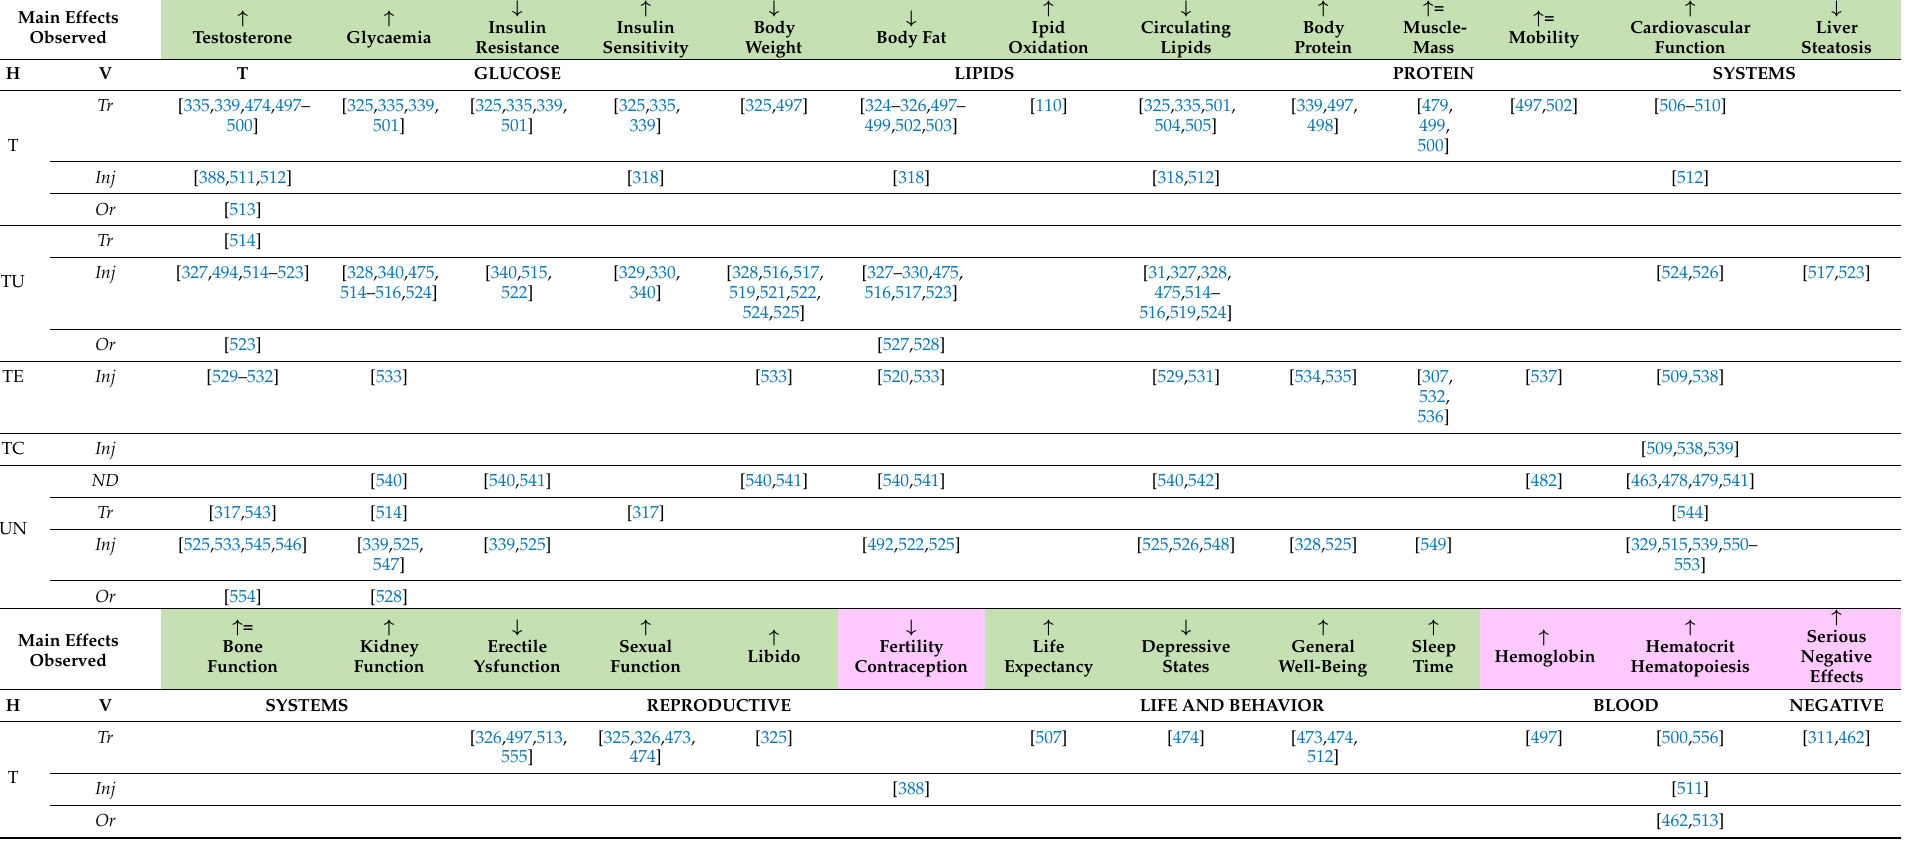
Table 2. Main effects on men of prolonged “testosterone” replacement treatments using either T or